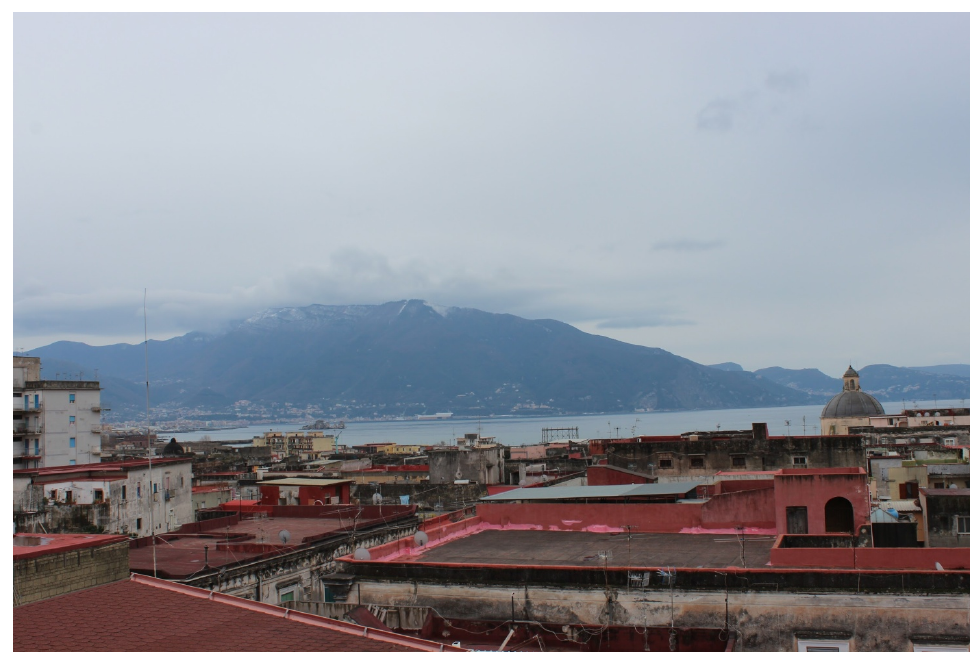
Figure 6: View from buildings roofs in Murat district with Sorrento and its coast in the